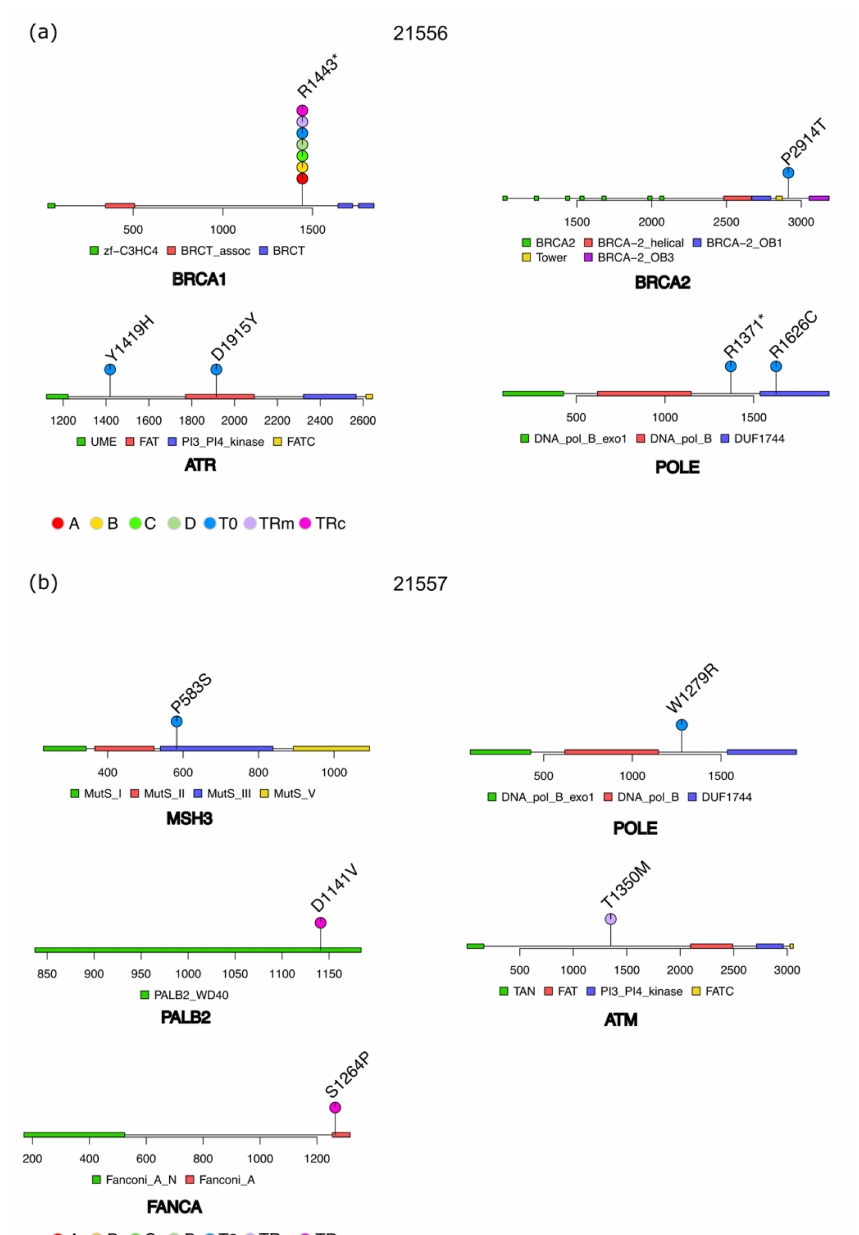
Figure 4. Lolliplots showing actionable variants in two representative patients, namely, 21556 ( a ) and 21557 ( b ). The name of encoded proteins is reported below each graph and the related protein domains, as described in the legend. Actionable variants are reported in correspondence of their amino acid position and named as reported above each dot. Dots represent the presence of an actionable variant in tumor and/or plasma samples, as indicated by the color in the